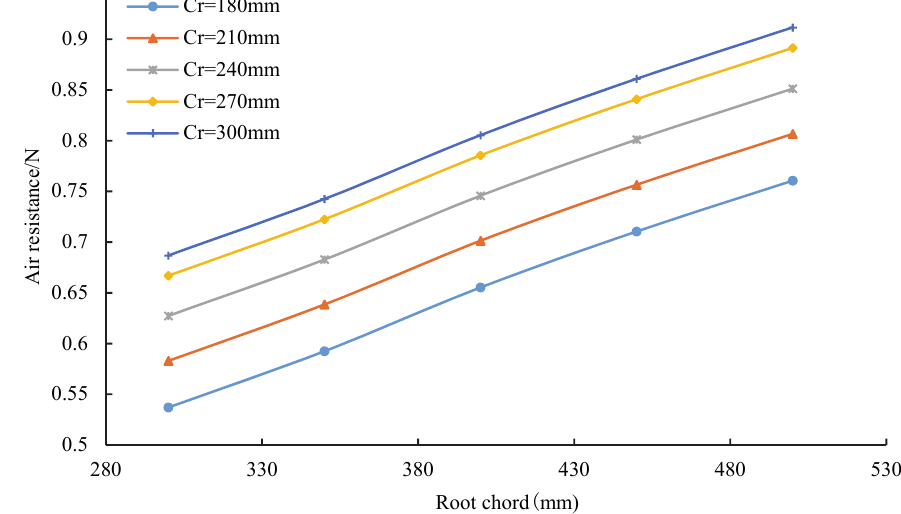
Figure 15. Relationship between the air resistance and wing root chord for different wingtip chord.